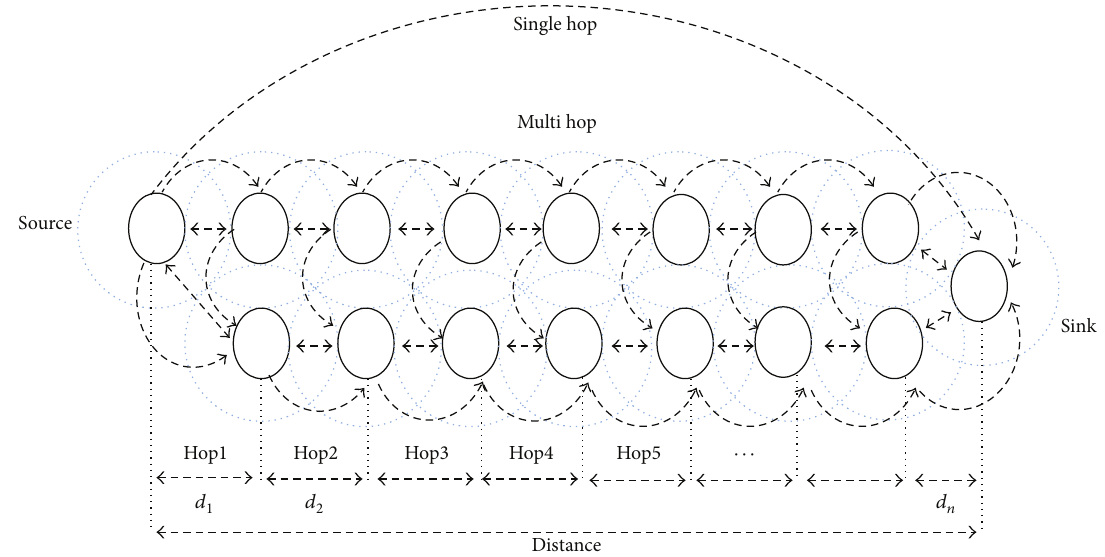
Figure 5: Linear energy consumption